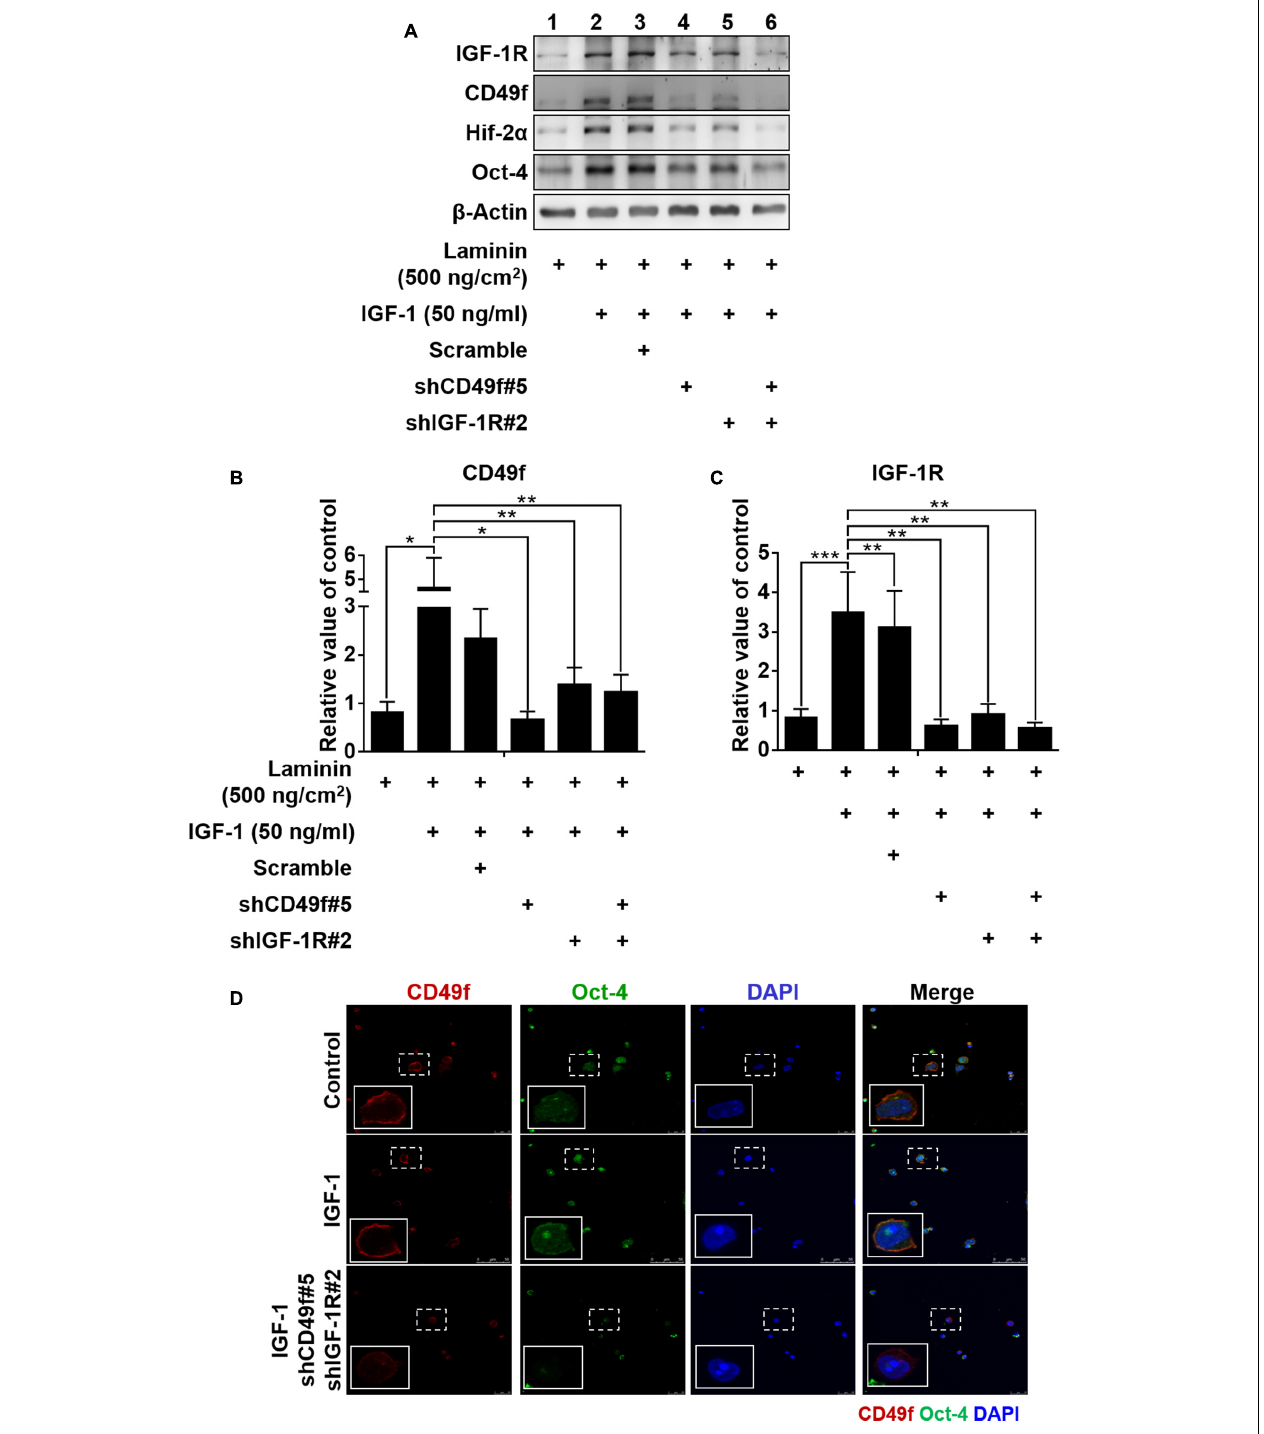
FIGURE 4 | Both IGF-1R and CD49f are required for IGF-1/laminin-mediated additive upregulation of CD49f, IGF-1R, Hif-2 α , and Oct-4 expression in CD49f + AP + GSCs. (A) Suppression effects of shCD49f and/or shIGF-1R on the expression of Hif-2 α , Oct-4, CD49f, and IGF-1R in CD49f + AP + GSCs treated with IGF-1 (50 ng/ml) on laminin-coated substrates (500 ng/cm 2 ). (B,C) The quantitative and statistical analyses of shCD49f- and/or shIGF-1R-mediated suppressing effects on the expression of (B) CD49f and (C) IGF-1R from (A) . Data are means ± SEM of at least three independent experiments. * p < 0.05; ** p < 0.01, *** p < 0.001 (one-way ANOVA). (D) The suppressing effect of shCD49f and shIGF-1R on cellular localization of immunocytochemistry stained Hif-2 α and Oct-4 in CD49f + AP + GSCs treated with IGF-1 (50 ng/ml) on laminin-coated culture plates (500 ng/cm 2 ).